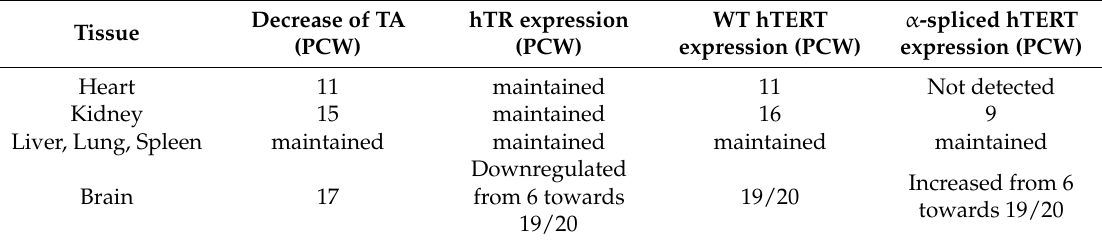
Table 3. Comparison of telomerase activity and expression of telomerase-related genes. Expression of hTR, WT hTERT and α -spliced hTERT in fetal heart, kidney and liver refer to data from [8,9] while data for brain are from this study. Numbers correspond to post-conception weeks at which hTR, WT hTERT or α -spliced hTERT were downregulated. PCW is two weeks more than the gestational weeks shown in